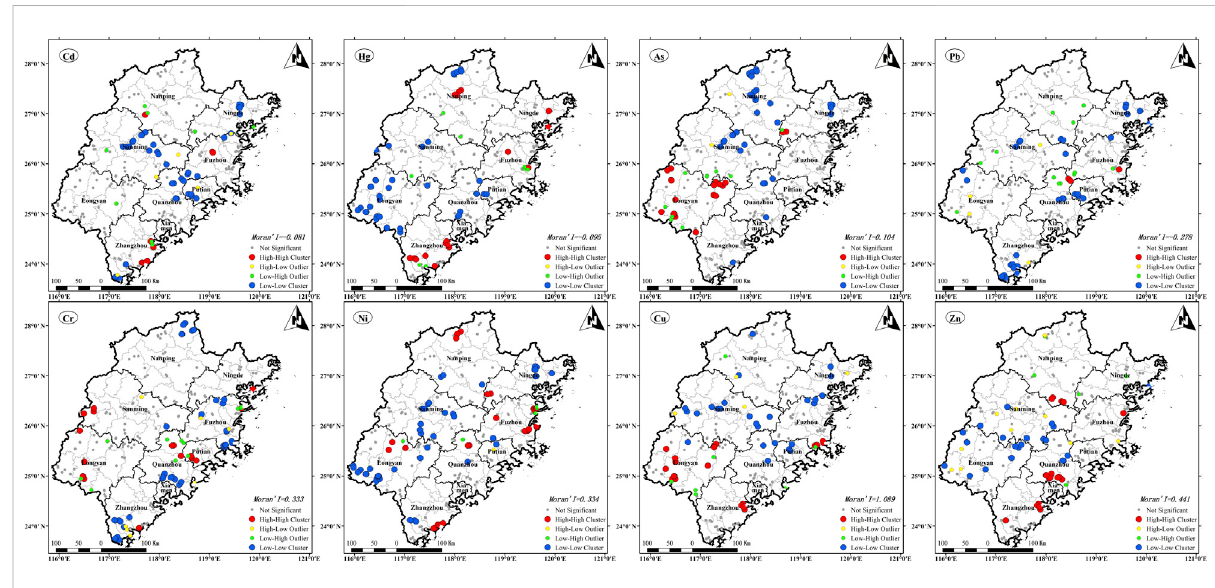
FIGURE 4 Spatial clustering of heavy metals in rice and distribution of outliers.